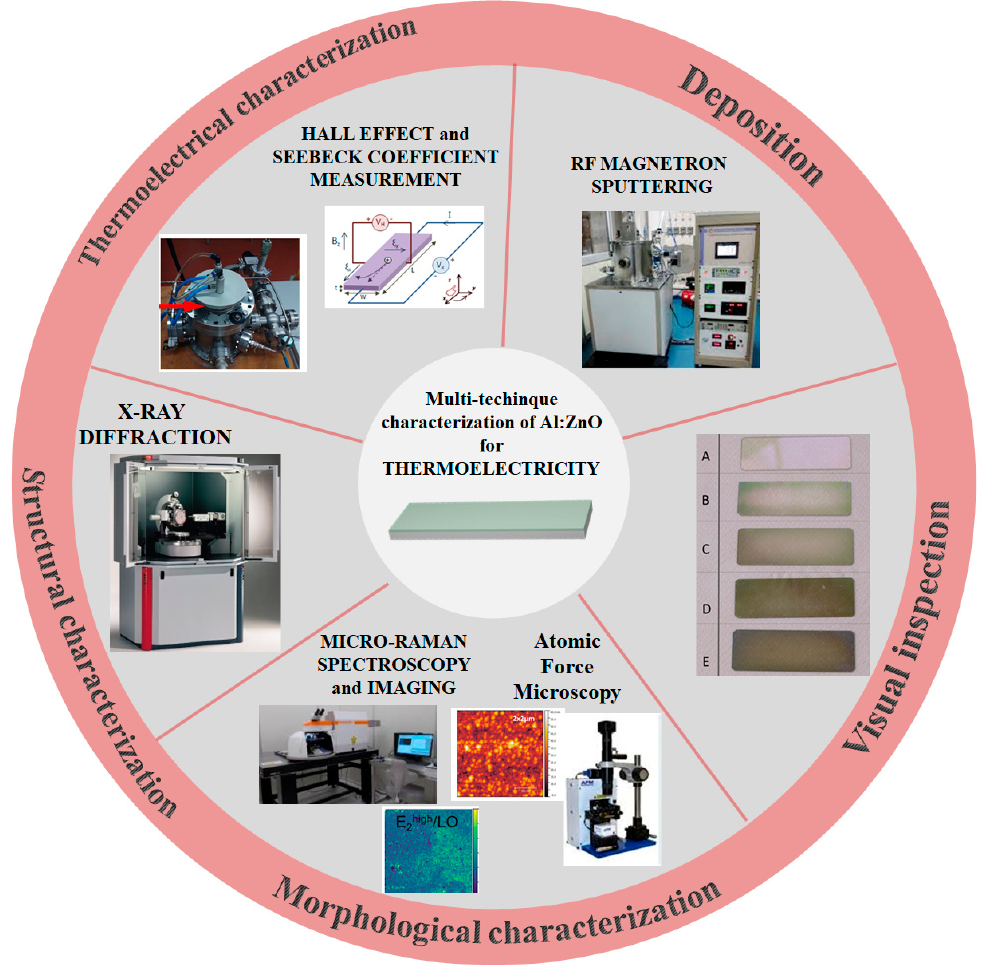
Figure 1. Sequence of experimental techniques employed in this study for the complete structural, morphological, electronic, and thermoelectric investigation of Al:ZnO thin films: RF magnetron sputtering deposition for the growth of thin films with varying levels of Al doping; optical and morphological investigation by visual inspection; AFM and Raman imaging; structural investigation by XRD and Raman spectroscopy; electronic transport and thermoelectric measurements. Table 1. Samples description, Al-doping concentration resulting from the RF sputtering power applied to the Al target. X and X’ are two nominally identical replicas of the same